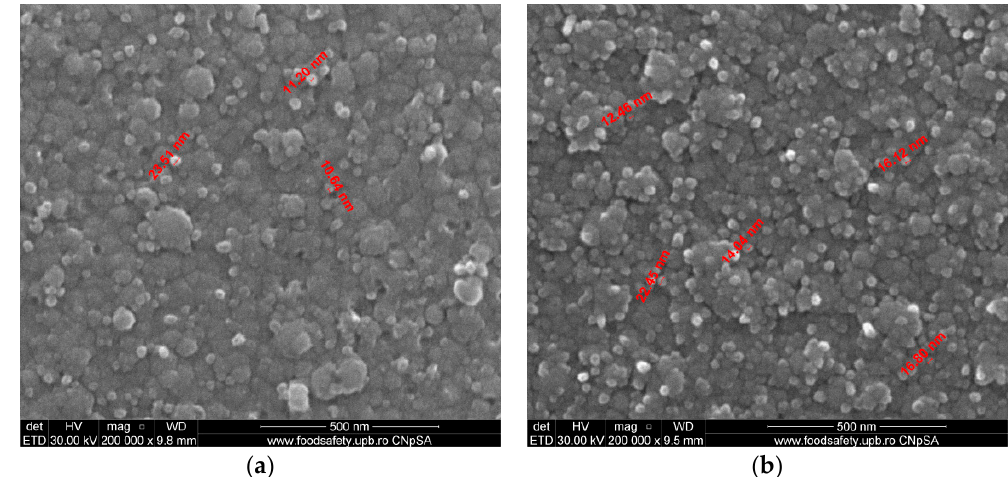
Figure 6. FE-SEM analyses of samples composed of Co-Cr alloy produced by DMLS and coated with a thin film of Ta 2 O 5 (50%) and ZnO (50%) using an e-gun: ( a ) sample S5 without post-treatment; ( b ) sample S6 with post-treatment (×200,000).